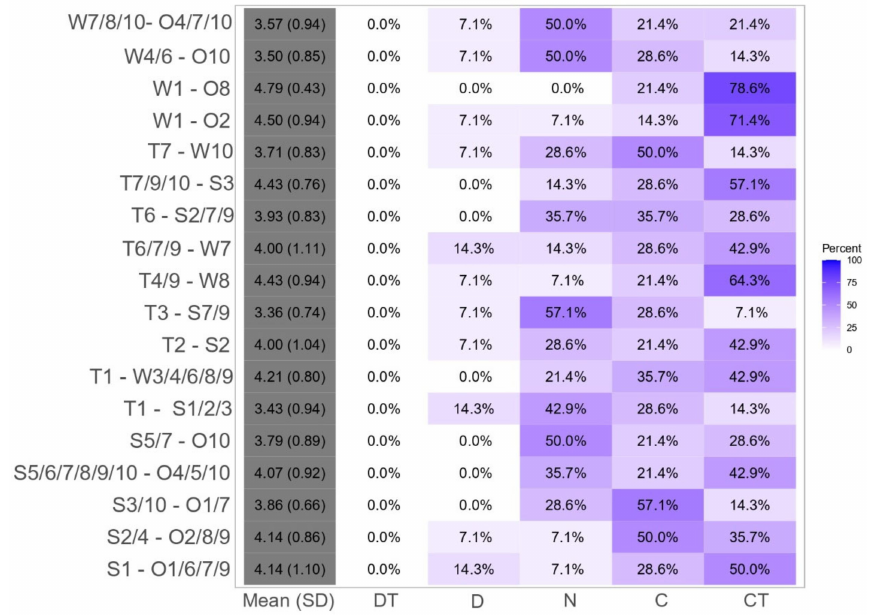
Figure 4. The scores of the proposed strategies after expert